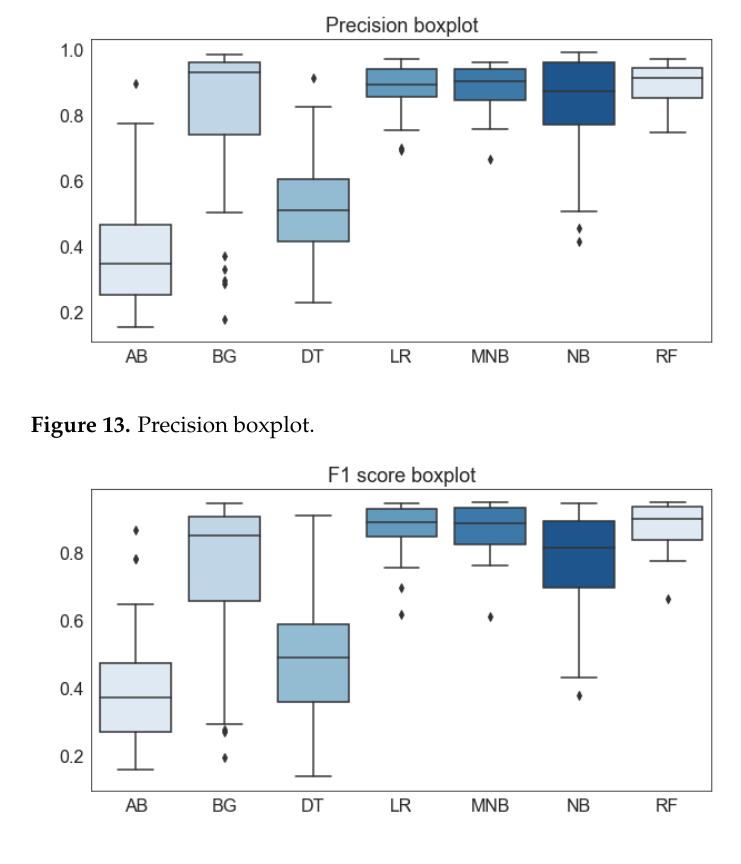
Figure 14. F1 score